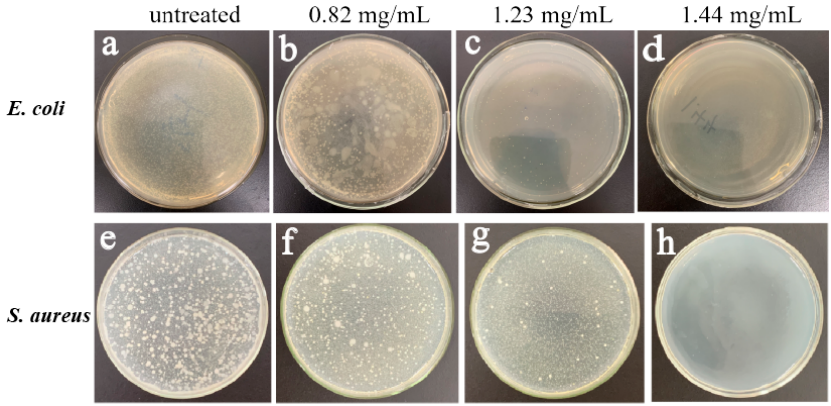
Figure 5. Photographs of culture dishes containing E. coli ( a – d ) and S. aureus ( e – h ) treated with 0, 0.82, 1.23, and 1.44 mg/mL, respectively.